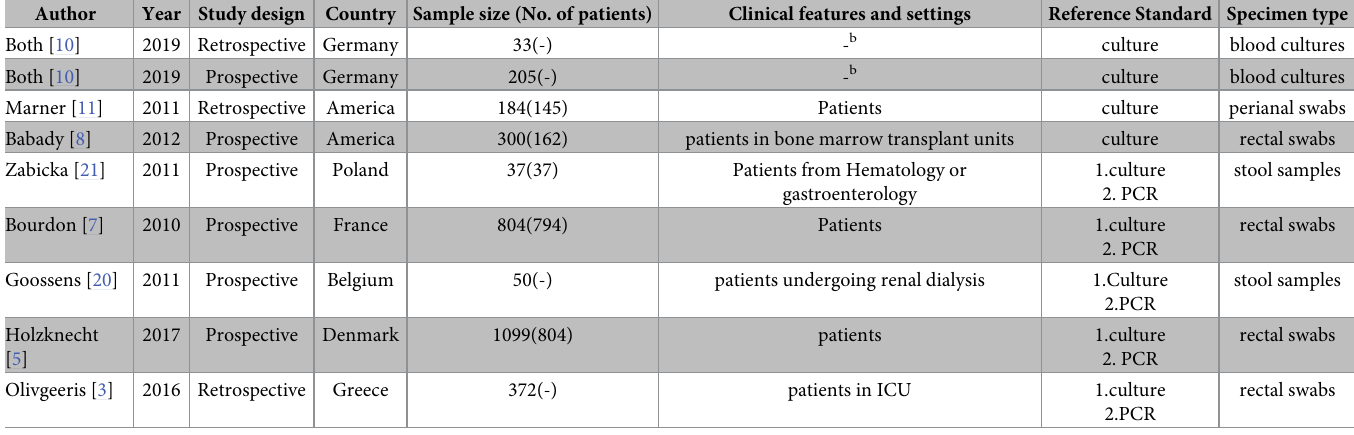
Table 1. Basic characteristics of included studies